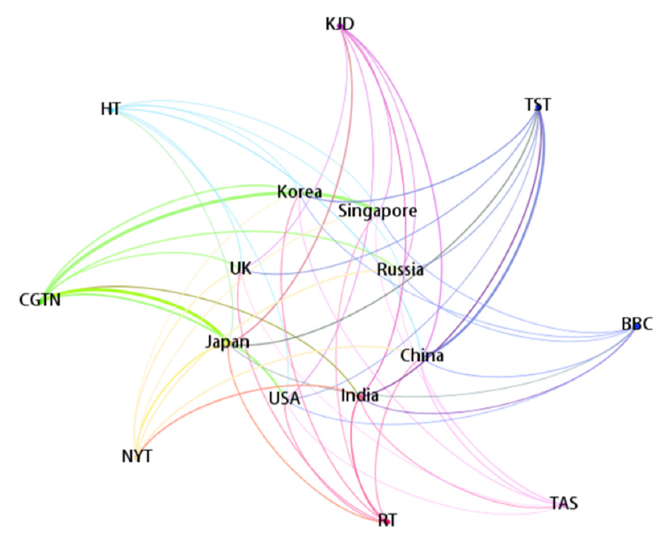
Figure 6. The number of COVID-19-related articles be positive.